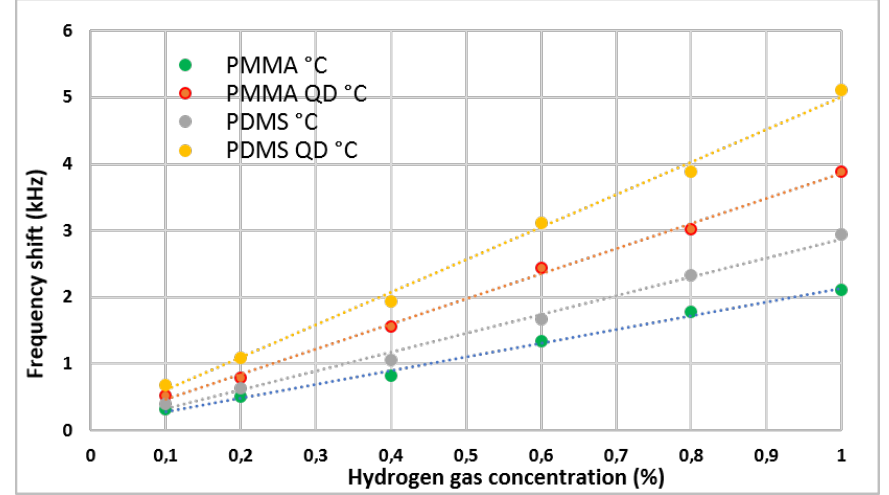
Figure 5. Frequency shift of the sensors after heat treatment for different concentrations of hydrogen.